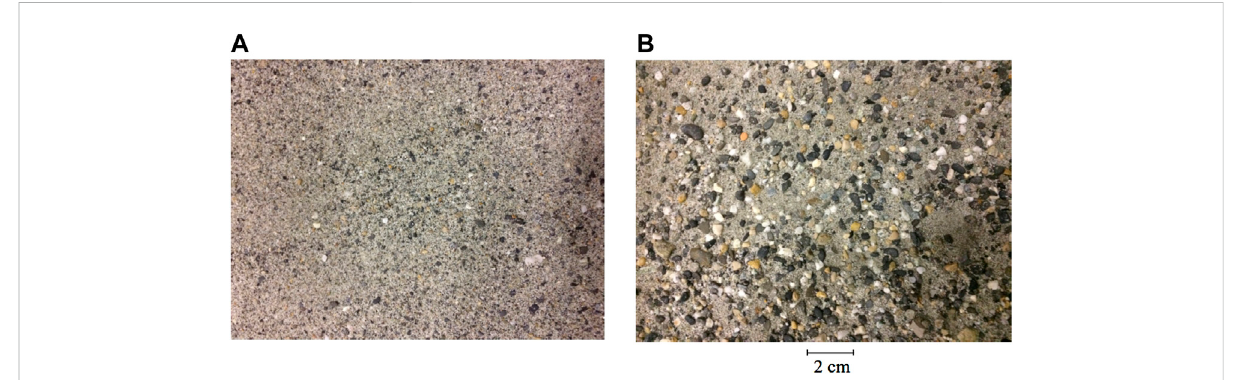
FIGURE 5 Flume surface at t = 0 (A) and t = 16 h (B) . This fi gure is from Cheraghi et al. (2018).